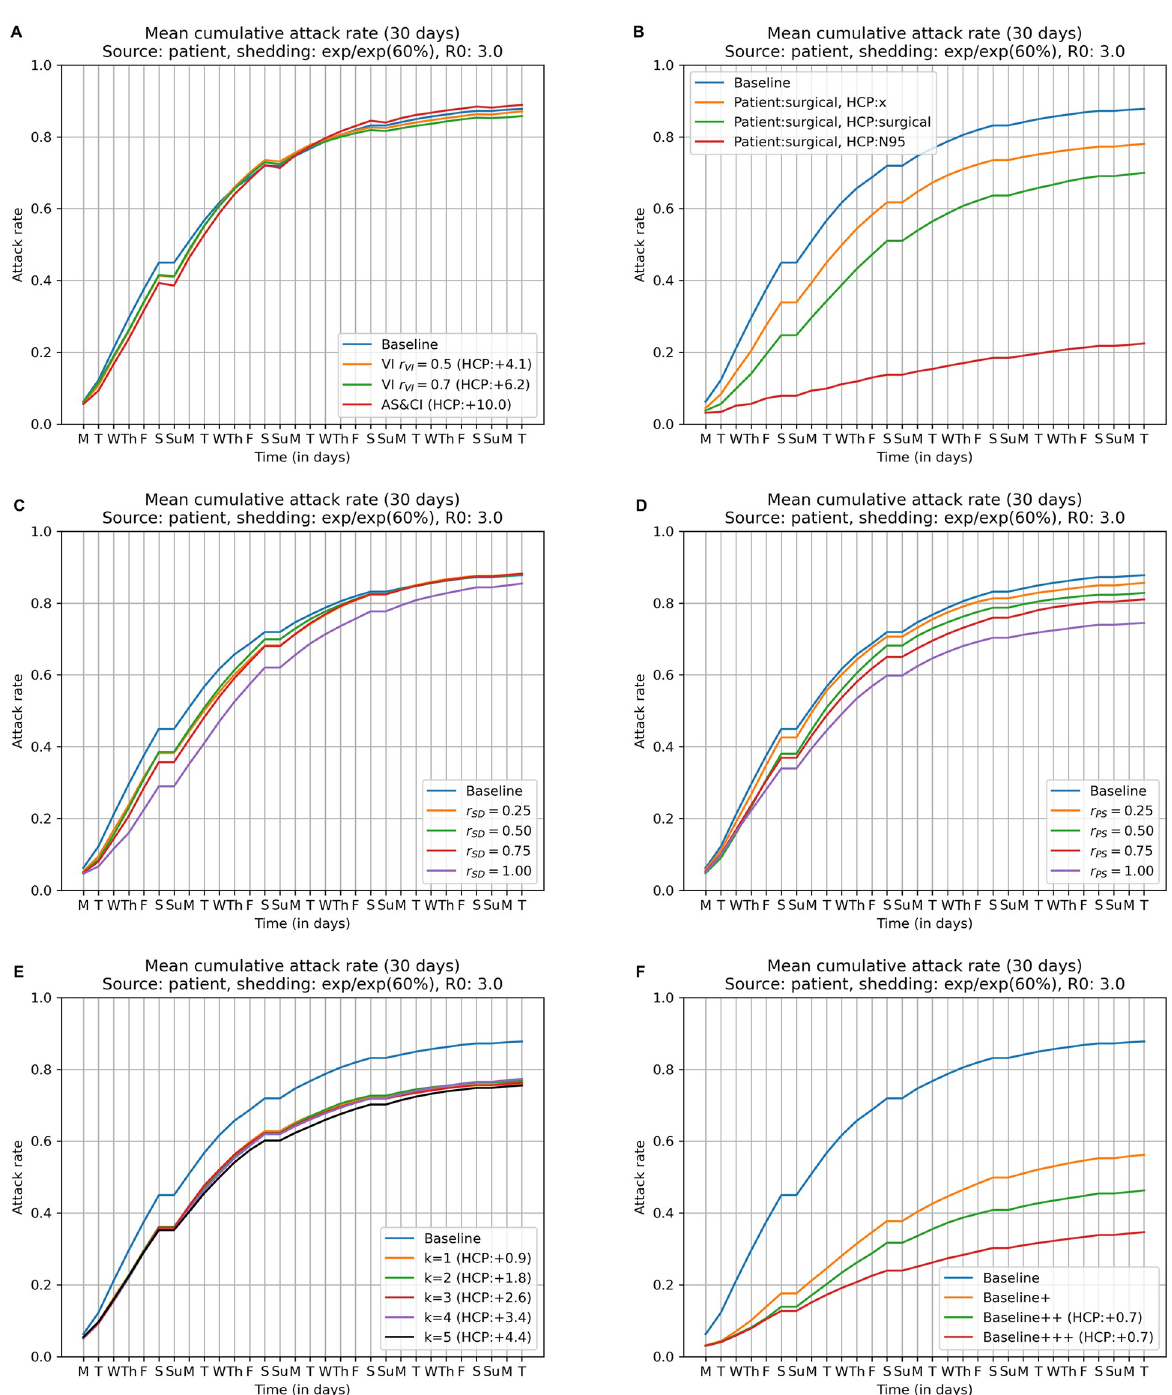
Fig 5. Attack rates for individual NPIs and selected NPIs in combination in Scenario 1 (infection source: Dialysis patient), R 0 = 3, exp/exp (60%) . (A) Voluntary self-isolation vs. active syndromic surveillance and compulsory isolation. (B) Use of masks and respirators. (C) Improved social distancing among HCPs. (D) Increased physical separation of dialysis stations. (E) Patient isolation and preemptive isolation of exposed HCPs. (F) Combinations of inexpensive NPIs denoted Baseline+, Baseline++, and Baseline+++. Each figure displays cumulative attack rates as a function of simulation days. Each plot includes the Baseline curve for comparison; lower curves correspond to fewer infected agents. See text for descriptions of the individual